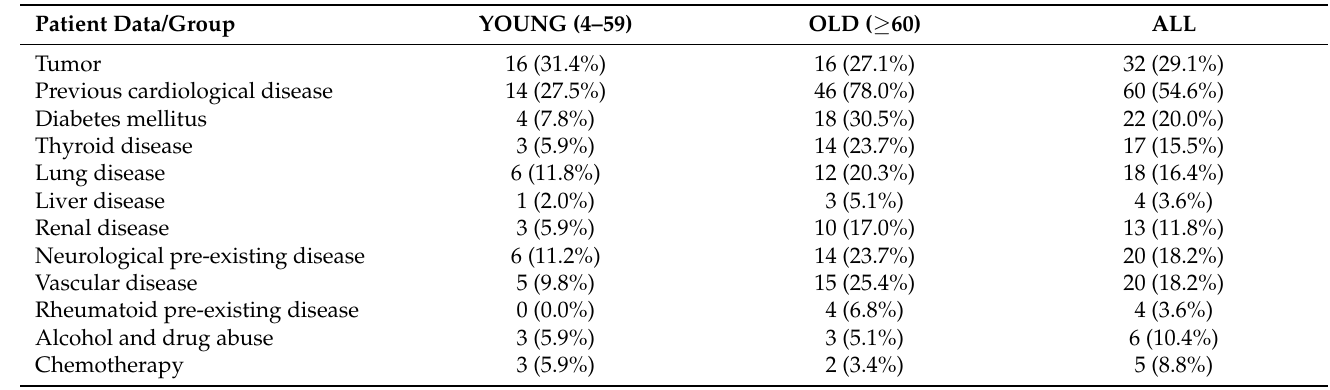
Table 2. Presentation of concomitant diseases of the studied cohort of patients and the division into the two groups (YOUNG, OLD).